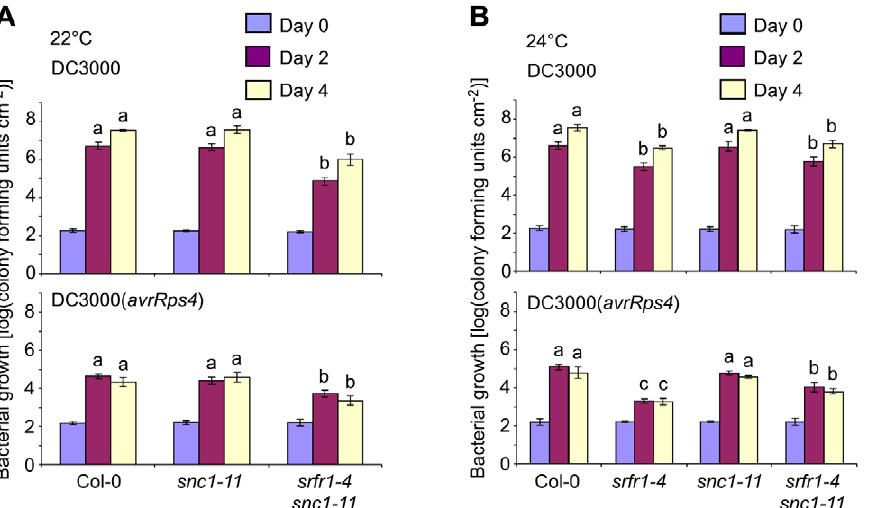
Figure 5. Phenotypically normal srfr1-4snc1-11 double mutants show enhanced basal defense and AvrRps4-triggered immunity. In planta bacterial growth was measured in the indicated plant lines on day 0 (blue bars), day 2 (purple) and day 4 (yellow) after inoculation with DC3000 (top) and DC3000( avrRps4 ) (bottom) at 5 6 10 4 cfu/ml at 22 u C (A) and 24 u C (B). Values represent averages of cfu/cm 2 leaf tissue from triplicate samples, and error bars denote standard deviation. Values labeled with different letters show significant differences at the indicated days as determined by Student’s t-test ( P , 0.05, n=3). This experiment was repeated twice with similar results.